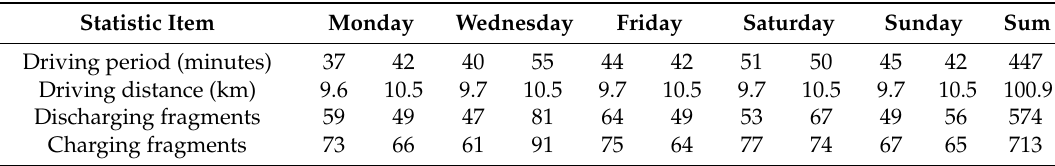
Table 2. Driving information